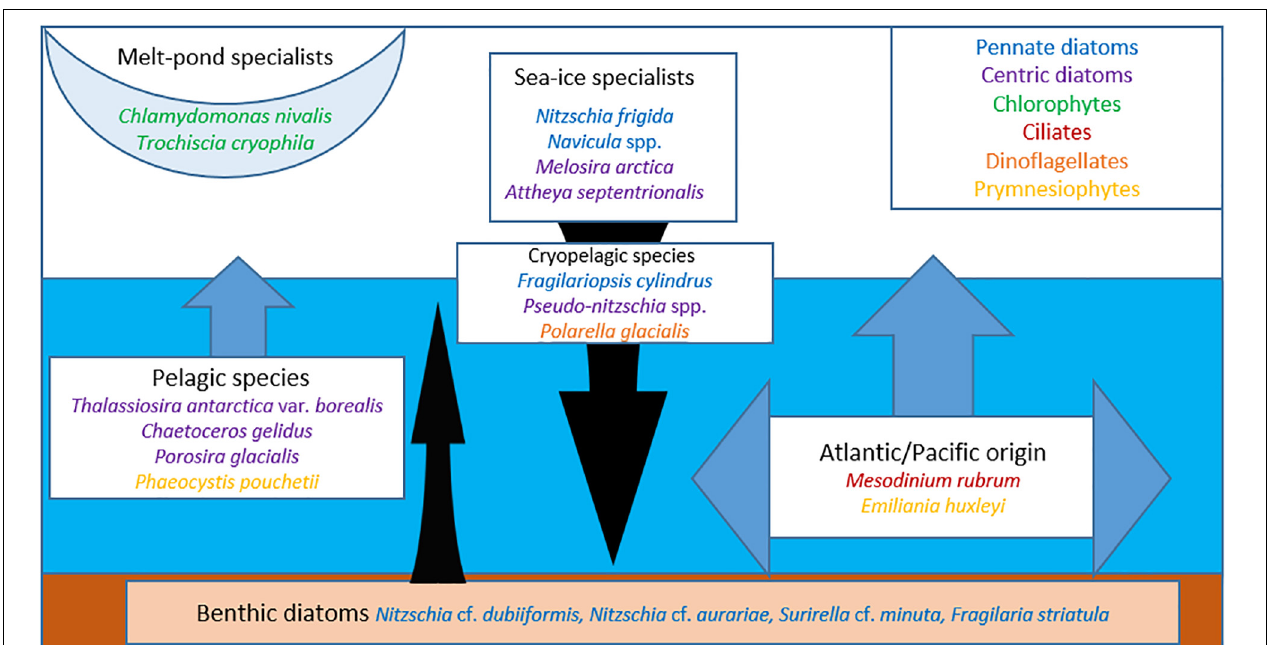
FIGURE 7 | Schematic habitat preference of sea-ice protists and associated taxa/groups. Pelagic and benthic diatom taxa are more associated with first-year sea ice, and most often incorporated during freezing. When sea ice melts the protists become part of the vertical